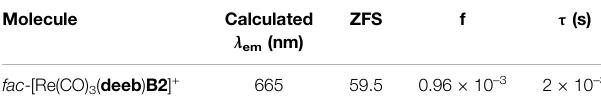
TABLE 4 | Calculated emission band considering solvent effects